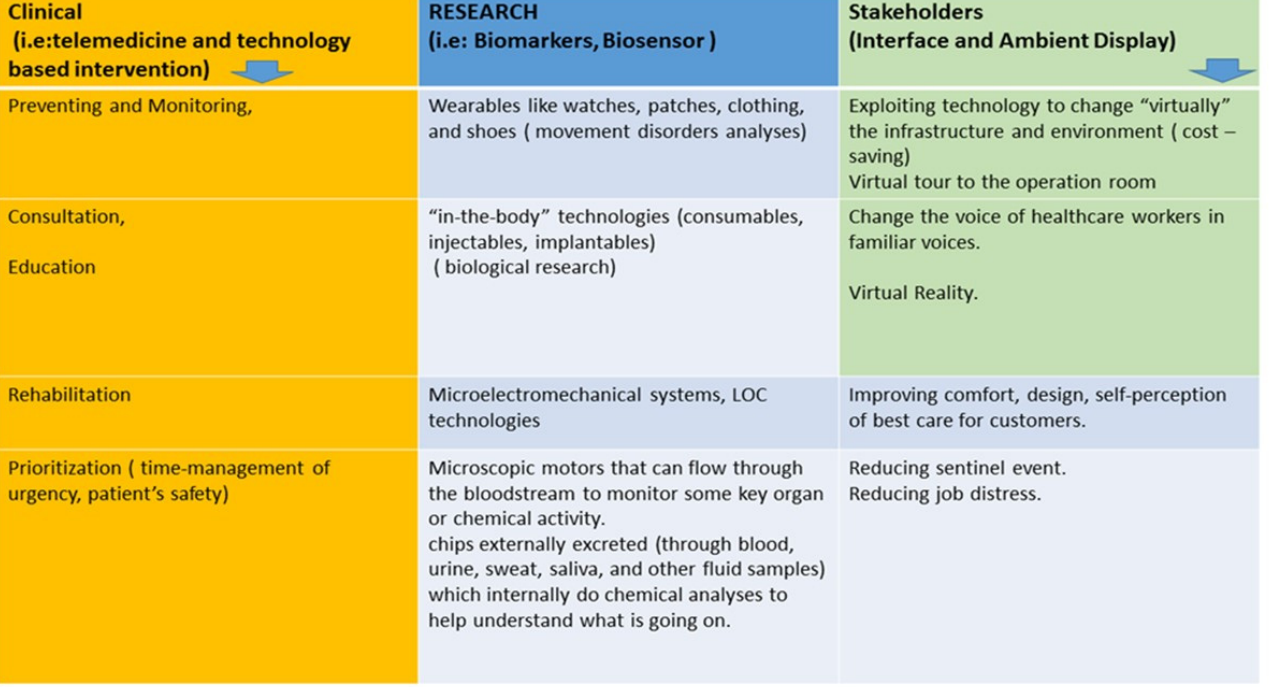
stress of healthcare workers when they deal with patients developing